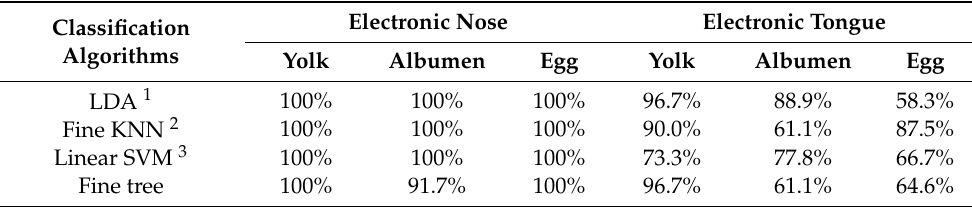
Table 7. Classification accuracy (%) of electronic sensory qualities from three breeds of eggs based on different